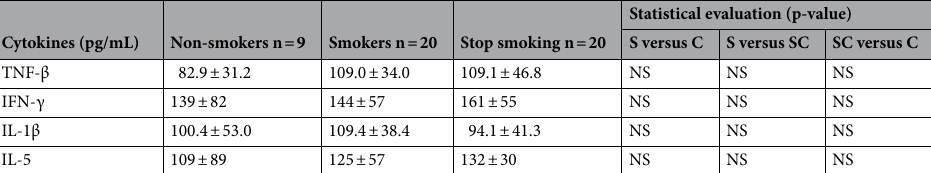
Statistical evaluation